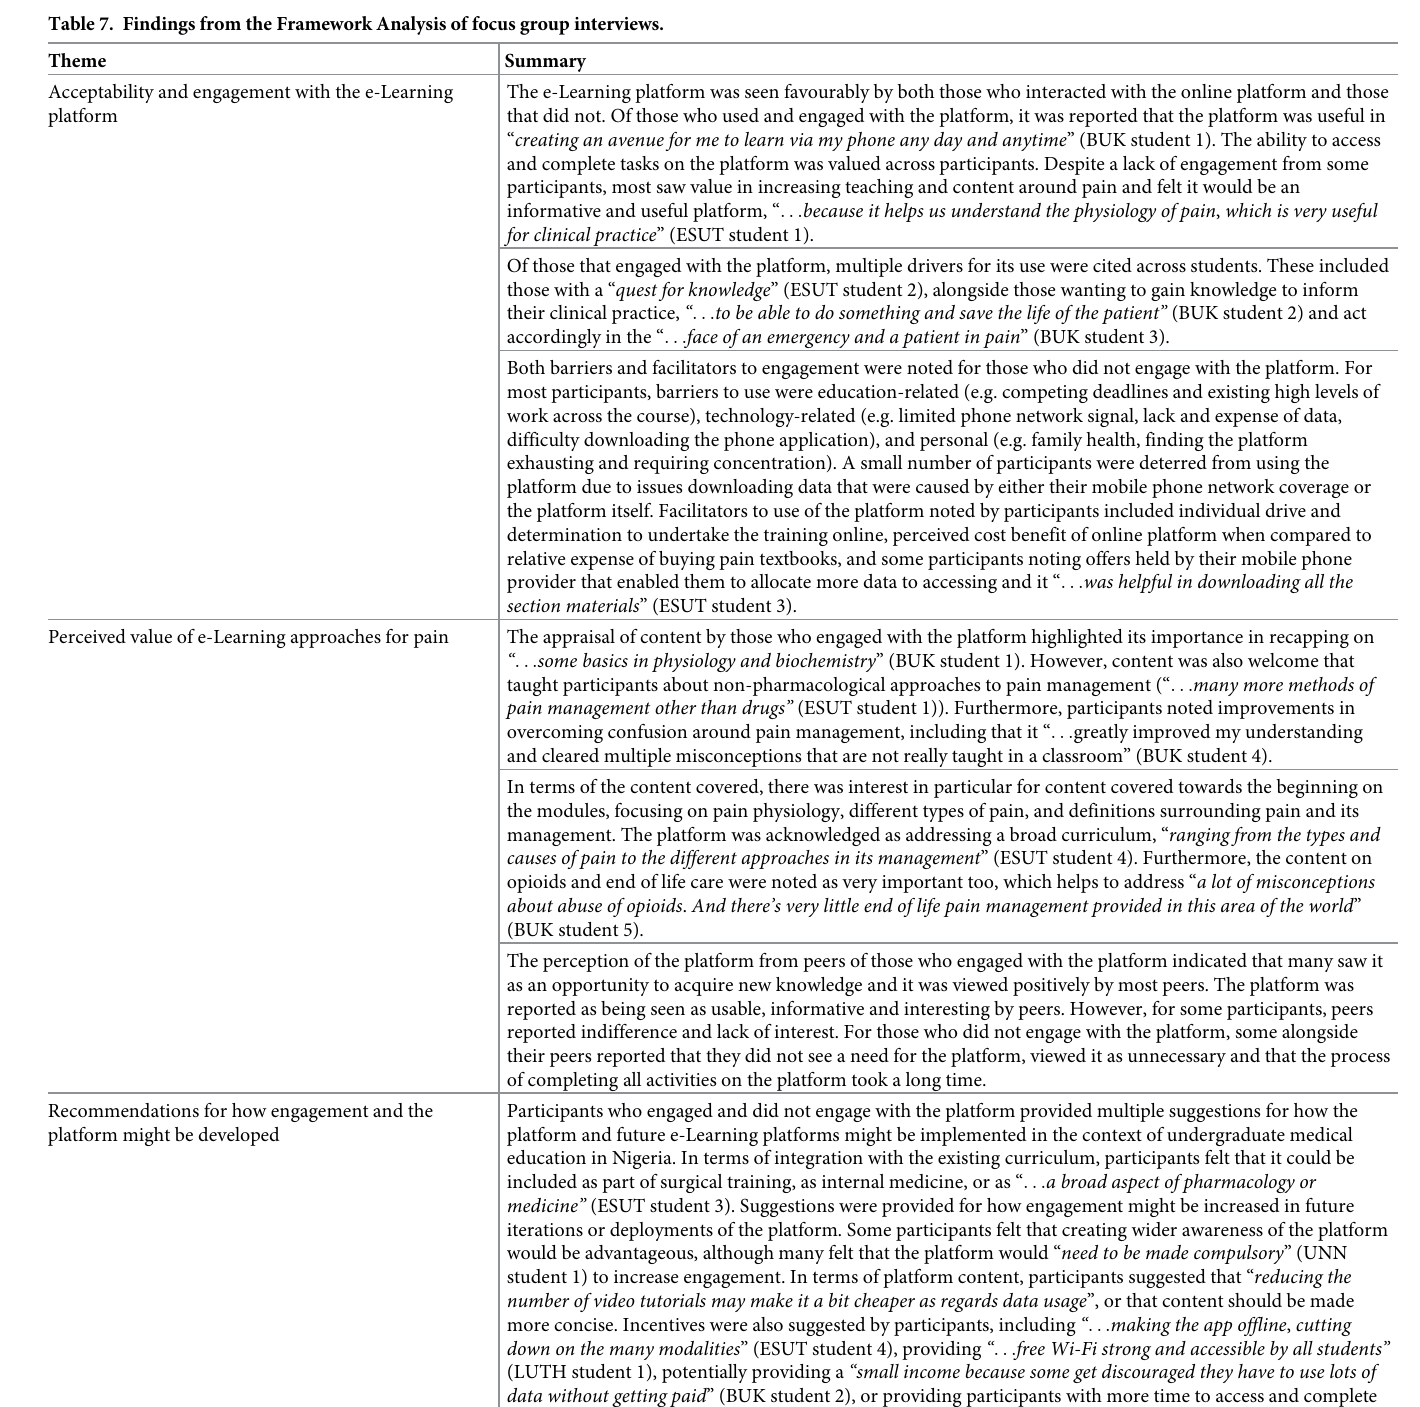
Table 7. Findings from the Framework Analysis of focus group